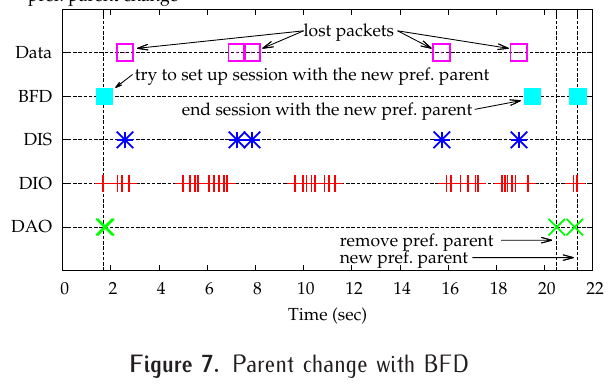
Figure 7. Parent change with BFD